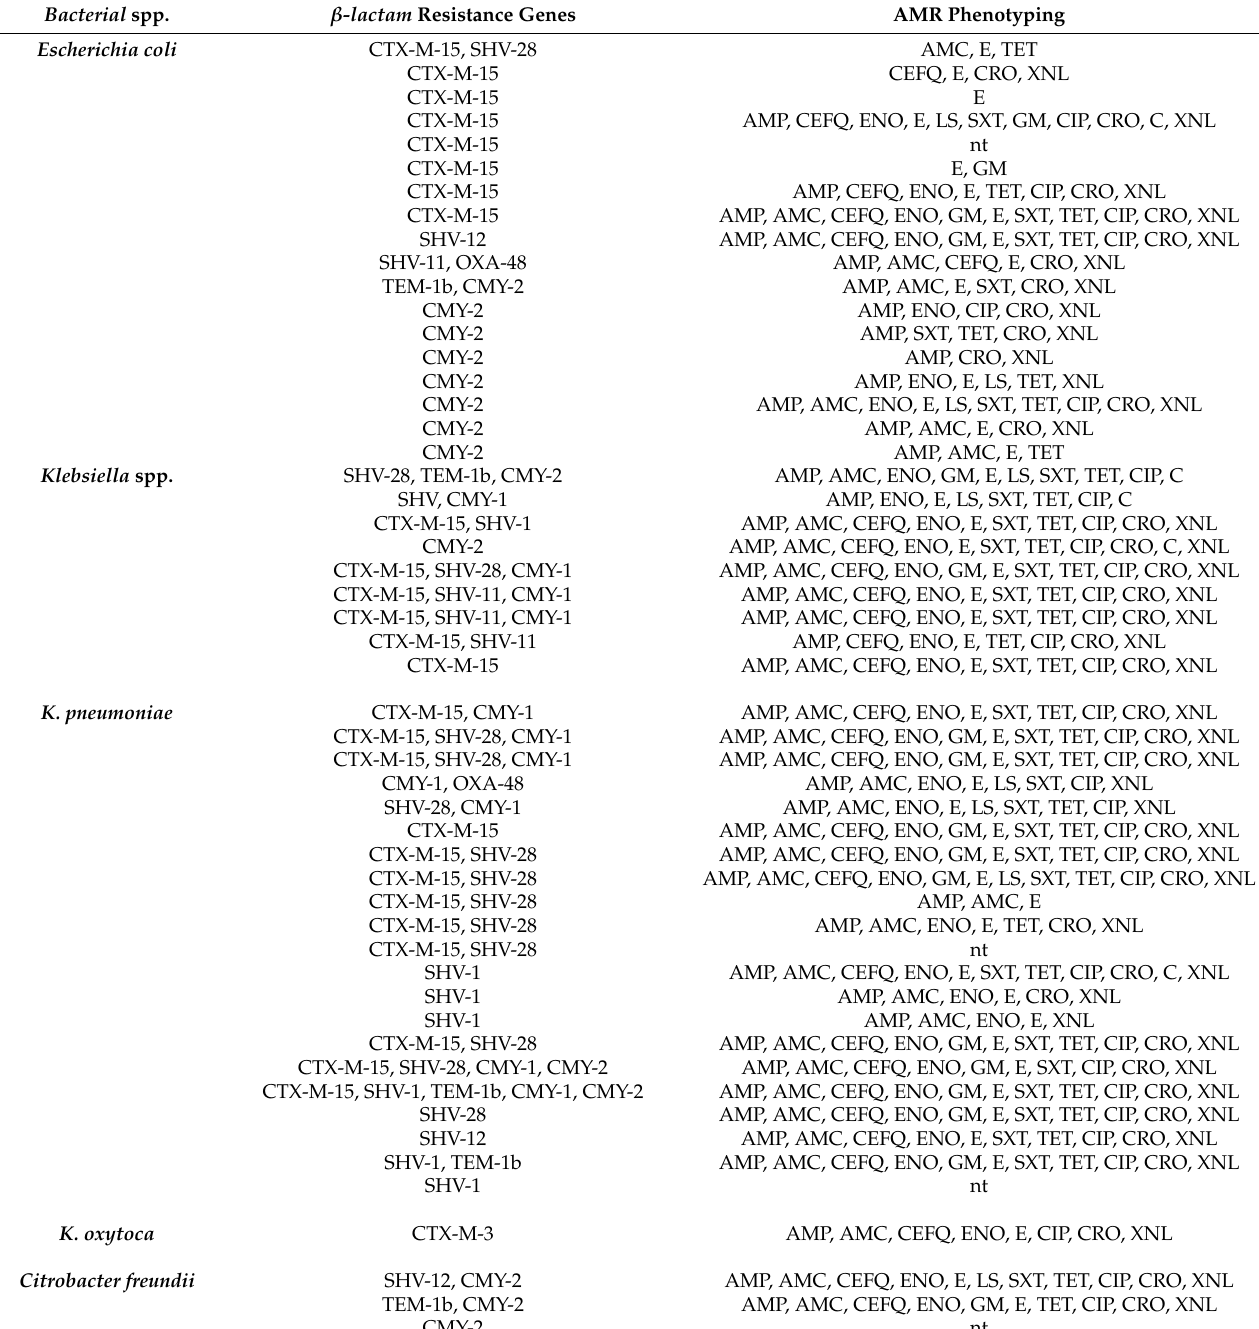
Table 2. Antimicrobial resistance genotypes and phenotypes of β -lactamase producing Enterobacteriaceae detected in wild European